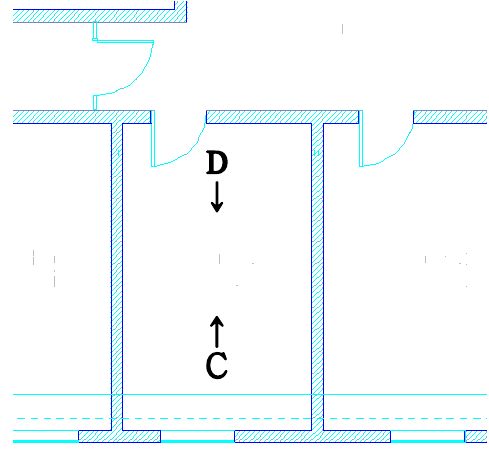
Figure 3. CAD plan of office and its surroundings